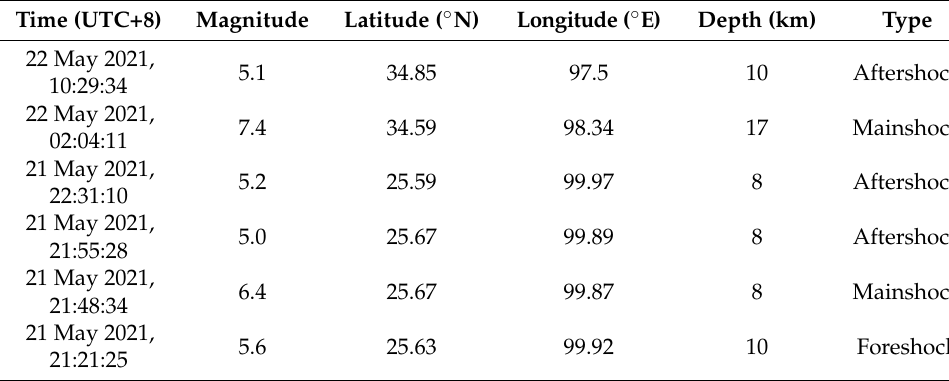
Figure 1. The epicenters of the earthquakes in 2021. Table 2. Seismic list around Madoi M7.4 and Yangbi M6.4